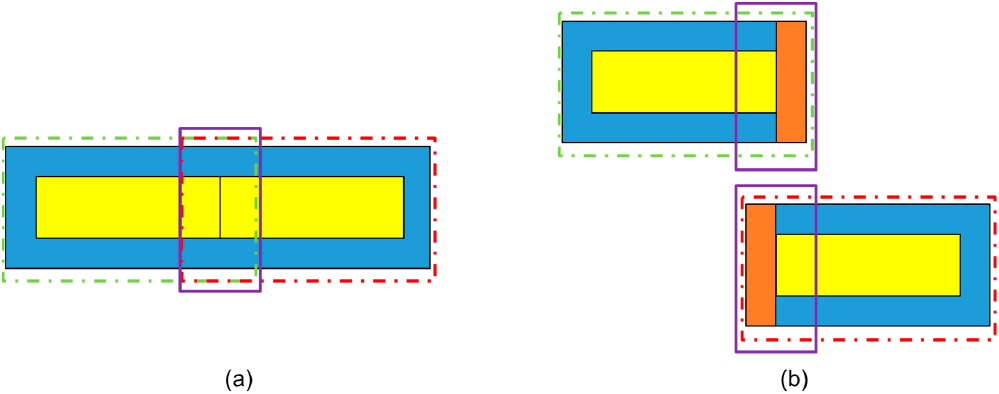
Figure 6. ( a ) The figure shows two patches (green dotted line and red dotted line) that overlap. The internal yellow regions are coherent. The overlap of the two patches is covered in the purple rectangle. ( b ) The figure shows how the orange margin with the potential for misclassification is covered by the overlap of the two patches. The overlapped part of each patch in the purple rectangle contains the margin in orange. Since we keep only the yellow region of each segmented patch, the orange margin is